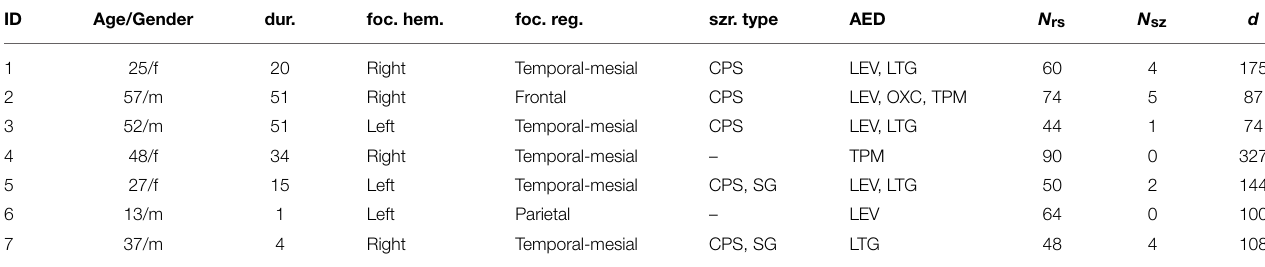
TABLE 1 | Clinical data of the patients.